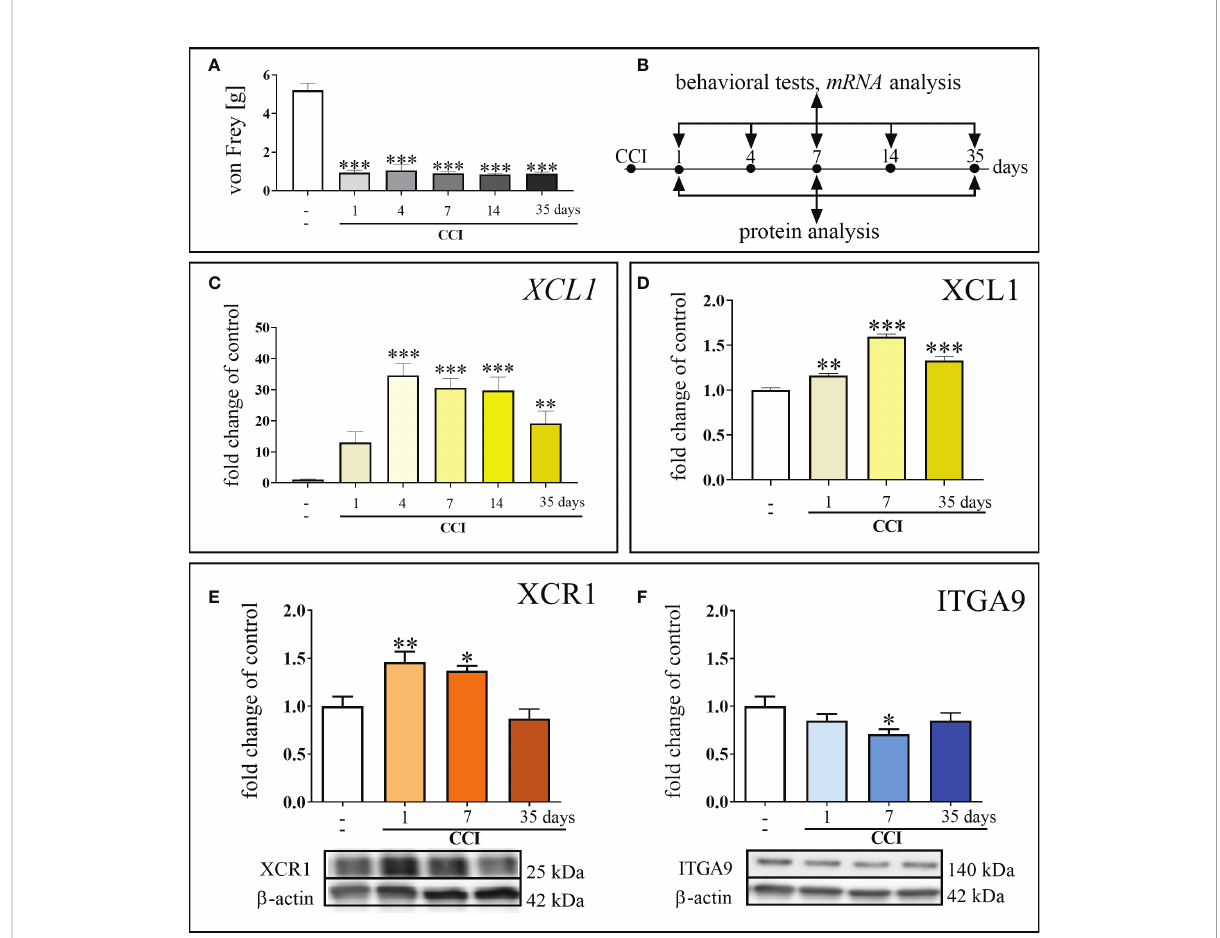
FIGURE 1 Development of mechanical hypersensitivity after chronic constriction injury (CCI) of the sciatic nerve in mice (1, 4, 7, 14, 35 days) (A) . Scheme of tissue collection at the indicated time points for behavioral tests and mRNA/p rotein analyses (B) . Time-dependent changes in the expression of XCL1 mRNA by RT – qPCR (C) and protein by ELISA (D) ; XCR1 protein by Western blot (E) and ITGA9 protein by Western blot (F) in the spinal cord of naive and chronic constriction injury-exposed mice (1, 4, 7, 14 and/or 35 days). The data are presented as the mean fold changes relative to the control ± SEM (n =5 – 10). The results were evaluated using one – way ANOVA followed by Bonferroni ’ s post hoc test for comparisons of selected pairs. ✽ p<0.05; ✽✽ p<0.01; ✽✽✽ p<0.001 indicate signi fi cant differences between the naive vs. CCI-exposed groups at each of the investigated time points: 1, 4, 7, 14, 35 days. “ - ”–